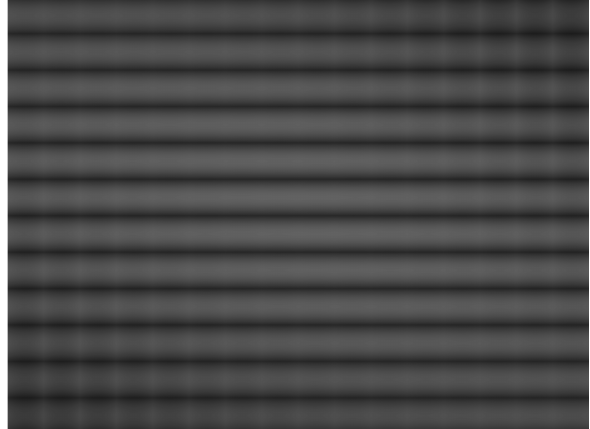
Figure 21. Radiometric profile for : (1) the stacked image ob- tained by accelerated transformation and bilinear interpolation, (2) the stacked image obtained by accelerated transformation and nearest